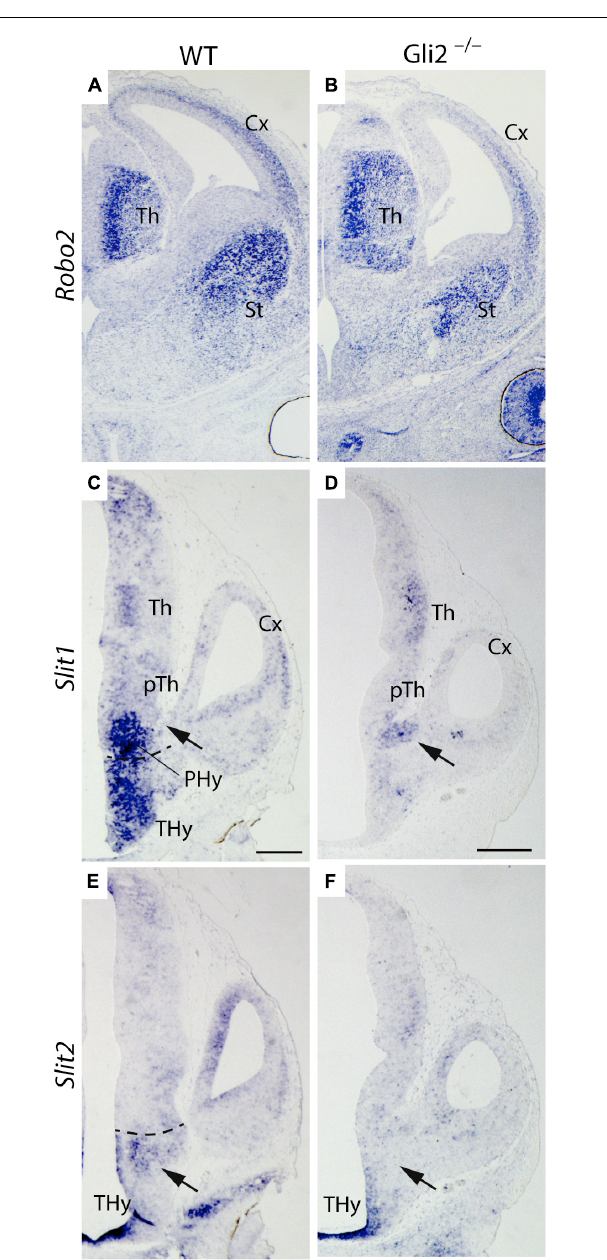
FIGURE 6 | Robo/Slit mechanism in TCAs pathfinding in Gli2 mutant mice. Frontal sections of E14.5 wild-type and Gli2 − / − brains with Robo2 in situ hybridization. Horizontal sections of E12.5 wild-type and Gli2 − / − embryos with Slit1 (C,D) and Slit2 (E,F) in situ hybridization. In (A,B) , Robo2 is detected in the thalamus, striatum, and cortex of wild type and Gli2 − / − . In (C) , Slit1 expression was founded in PHy and THy. A gap of expression is detected in the area where the TCAs cross (arrow). In (D) , Slit1 expression was localized in the zone used by the TCAs to enter the telencephalic vesicle (arrow). In (E) , Slit2 was detected in the midline of the THy and in a domain bordering the limit with the PHy (arrow). In (F) , the Slit2 expression in the mutant appeared only in the THy midline, being absent in the rest of the Thy territory (arrow). The dotted line indicates the limit between Thy and Phy. Cx, Cortex; PHy, peduncular hypothalamus; pTh, prethalamus; St, striatum; Th, thalamus; THy, terminal hypothalamus. Scale bar: 300 µ